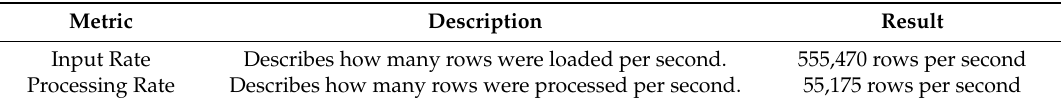
Table 10. Metrics used to evaluate our